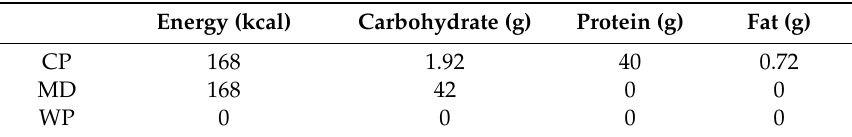
Table 1. Nutritional content of bedtime beverages. (CP: Casein Protein, MD: Maltodextrin, WP: Water